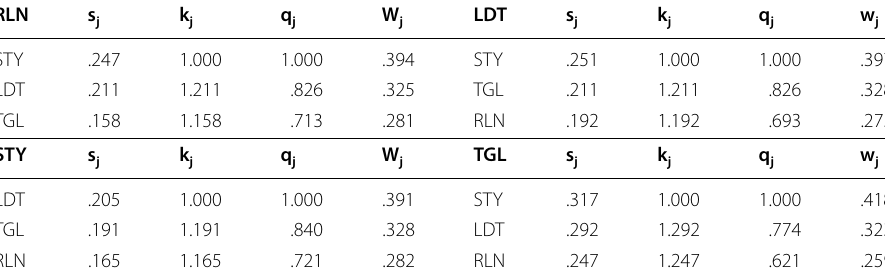
Table 6 sj, kj, qj, and wj values for the relationship degrees of each